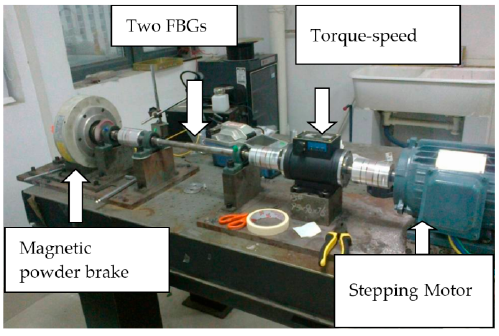
Figure 4. Experimental setup.